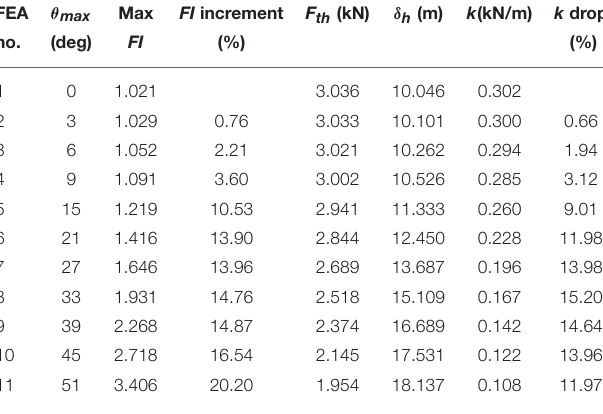
TABLE 6 | FEA results for the variation of θ max at the critical wind speed of 23 m/s. FEA θ max